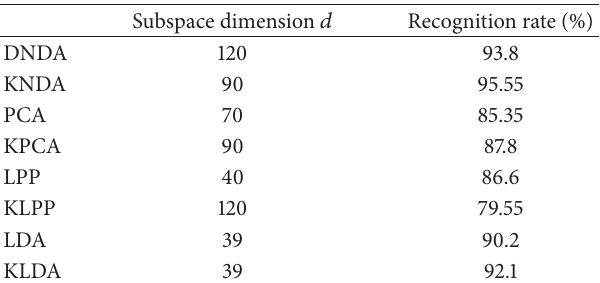
Table 1: The best recognition rate achieved by each method along with the corresponding subspace dimension 𝑑 .